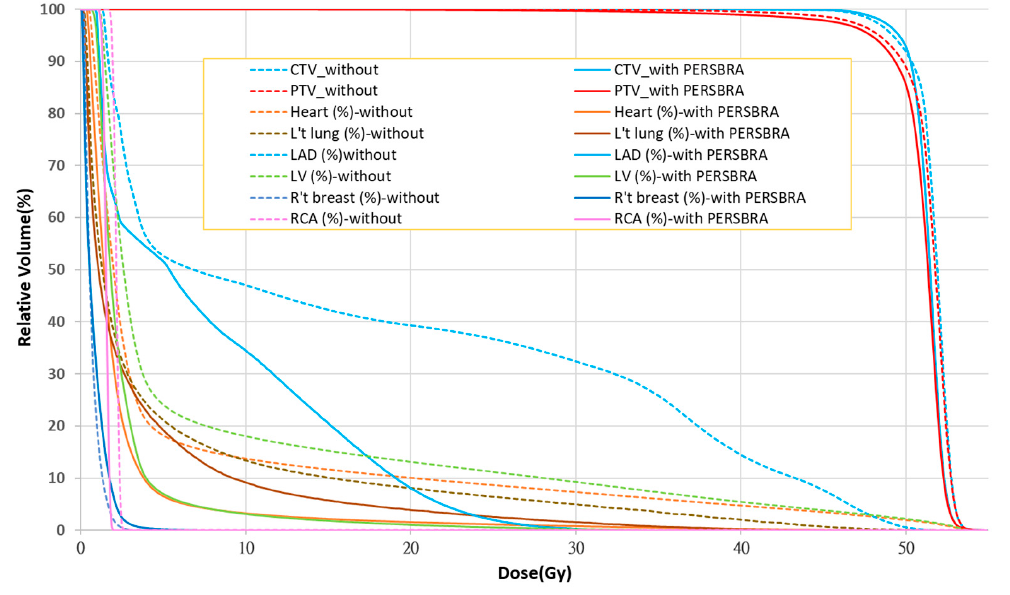
Figure 4. Comparison of the dose volume histograms (DVHs) between cases with and without PERSBRA. The solid line represents with PERSBRA; the dashed line represents without PERSBRA.